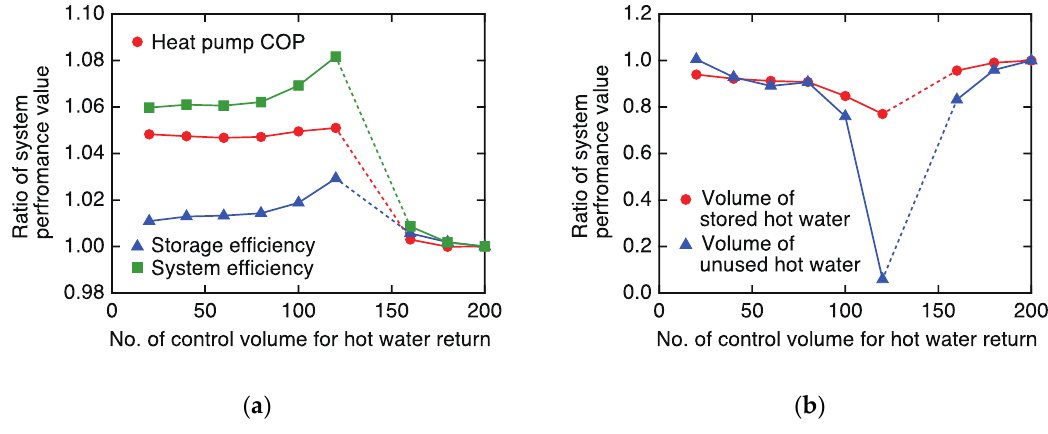
Figure 12. Influence of position for hot water return on system performance values: ( a ) heat pump COP, and storage and system efficiencies; ( b ) volumes of stored and unused hot